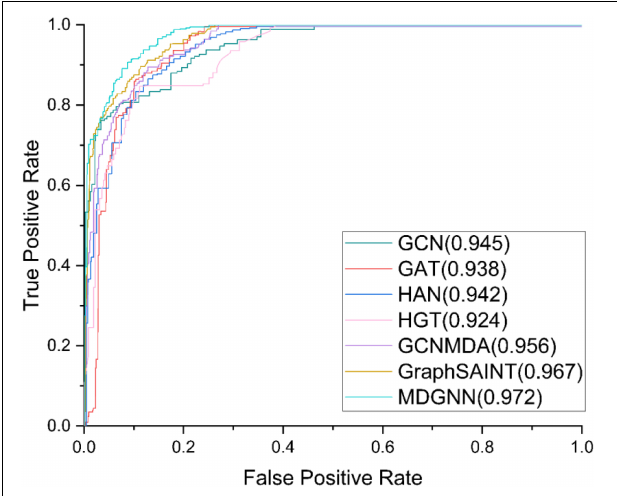
TABLE 3 | Comparative experiment of different benchmarks and MDGNN.